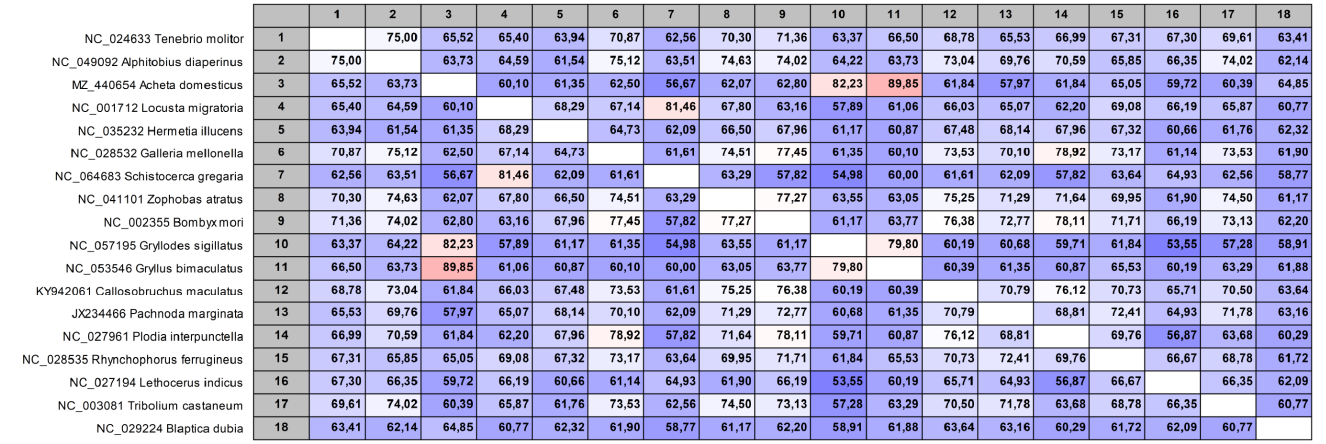
Figure 2. Multiple alignment of 18 reference samples. The figure was created with the pairwise comparison tool (CLC Genomics Workbench 11, Qiagen, Hilden, Germany). Table 3. Results for DNA extracts from reference samples. Numbers are average values ( n = 2, two sequencing runs, one